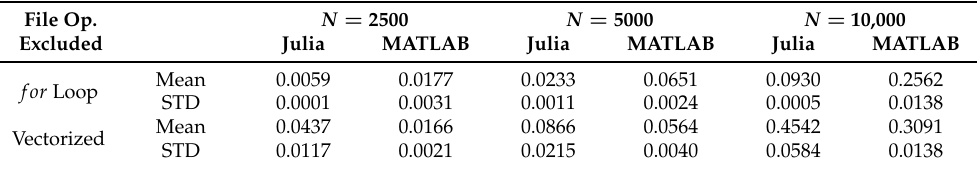
Table 2. Mean execution times and standard deviations of the Burgers’ equation solver written in MATLAB and Julia by excluding file operations. The mean execution times are given in second. Ten data points are used in the calculation of the mean and the standard deviation.